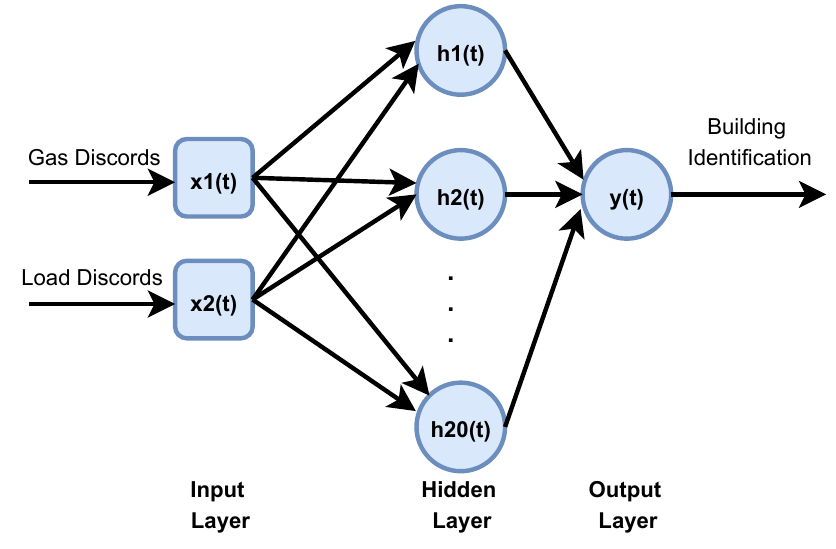
Figure 3. Architecture of the ANN-G+E